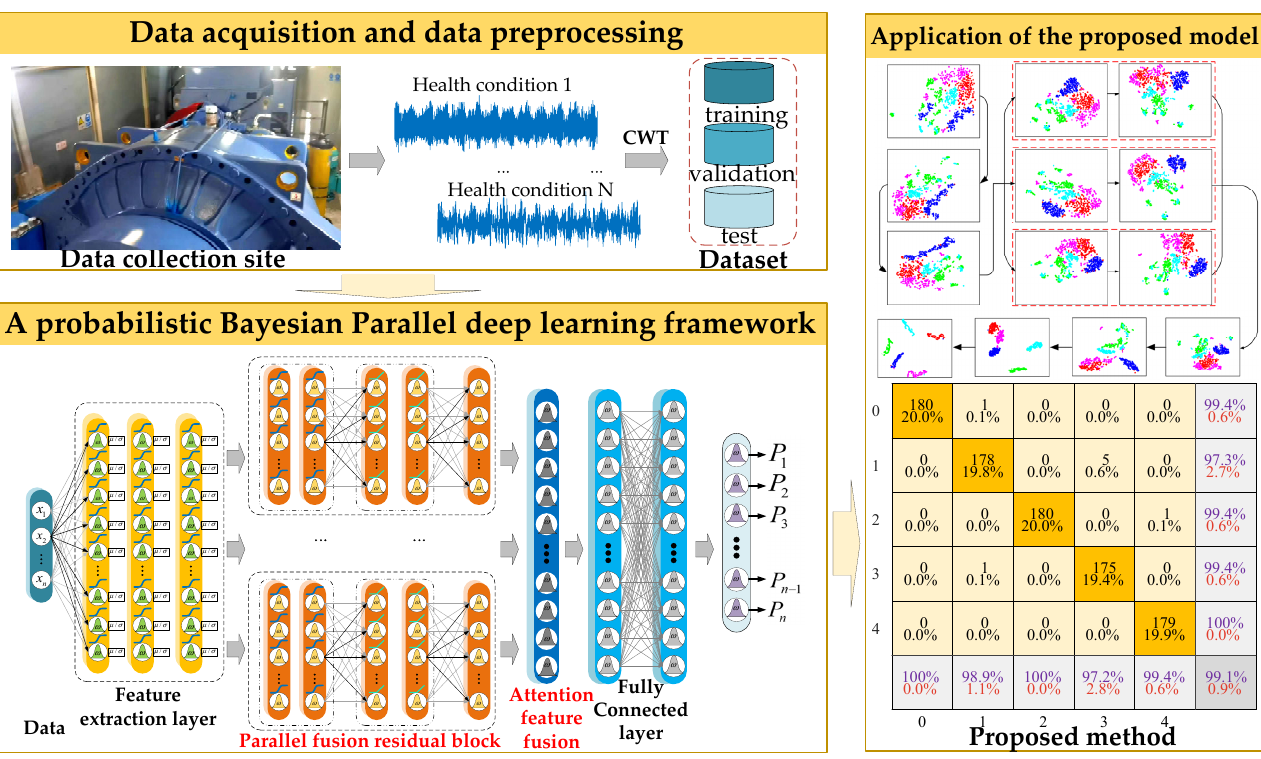
Figure 3. Fault diagnosis process of BayesianPDL framework.